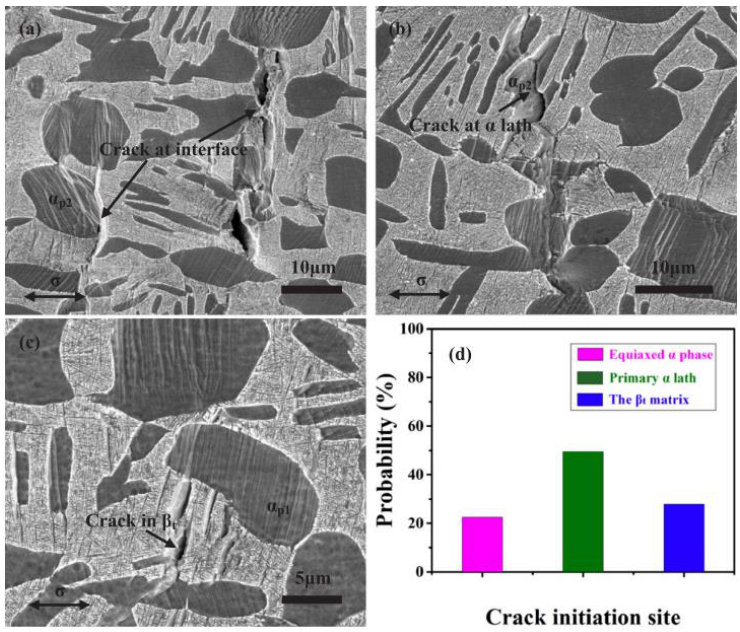
Figure 15. ( a ) Crack nucleation at interface of equiaxed α phase; ( b ) crack nucleation at α lath; ( c ) crack nucleation at interface of β-trans matrix; ( d ) probability of crack nucleation sites [106].